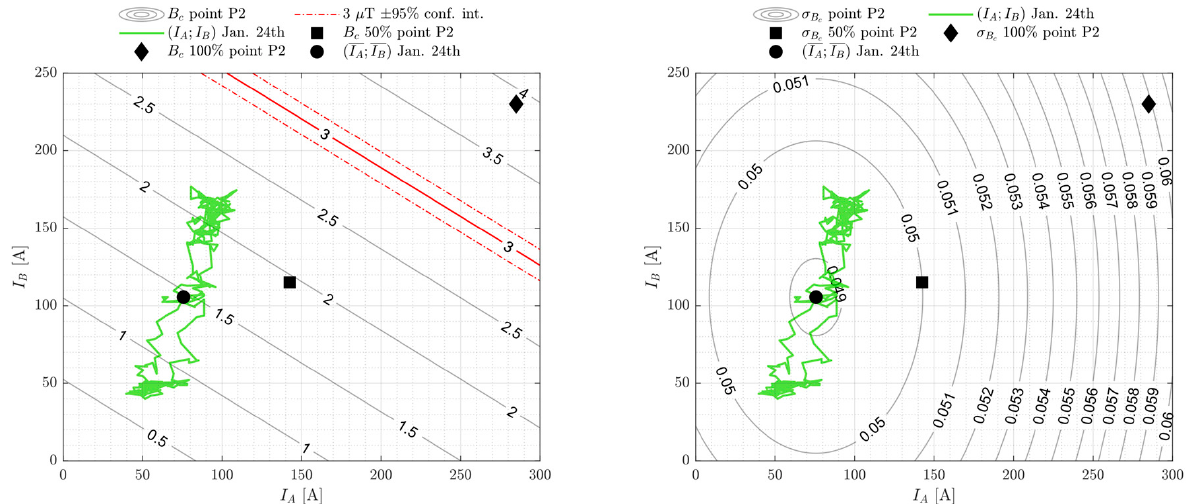
Figure 12. Positions P2 field ( left ) and its standard deviation ( right ) evolution (green trace) over the 24 h as a function of